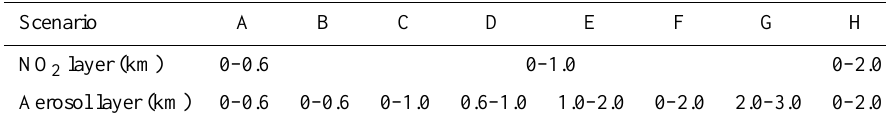
Table 1. Scenarios considered for the SCIATRAN runs, defined by the combination of a NO 2 and an aerosol layer, as in box profiles (e.g.,